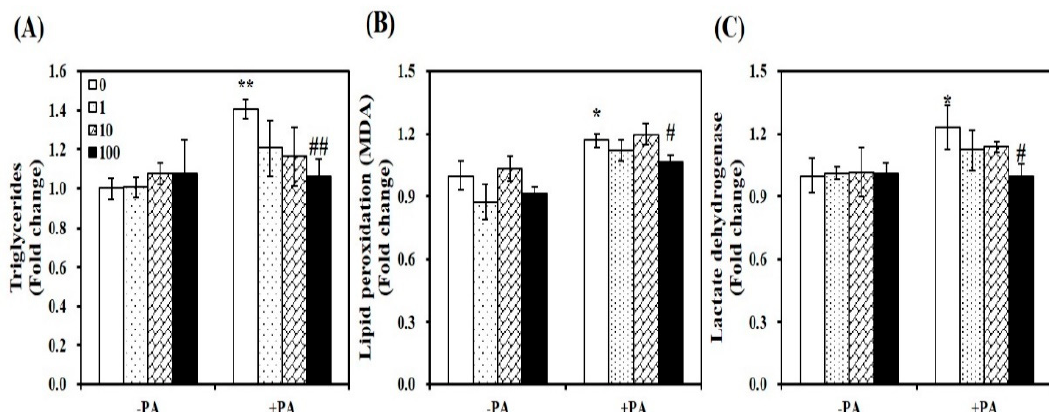
Figure 6. Inhibitory e ff ect of 1,25-dihydroxyvitamin D (1,25(OH)2D) on lipid accumulation, lipid peroxidation, and cellular damage. C2C12 myotubes were pretreated with palmitic acid (0.5 mM, 24 h) and then incubated with 1,25(OH)2D (0, 1, 10, or 100 nM, 24 h). Intramyocellular triglyceride concentrations ( A ), malondialdehyde (MDA) contents ( B ), and lactate dehydrogenase (LDH) levels ( C ) were expressed as the fold change compared to the vehicle control. Results are expressed as mean ± SEM. Experiments represent at least two or three independent experiments ( n = 6–10 per group). * p < 0.05; ** p < 0.01 compared to vehicle control. # p < 0.05; ## p < 0.01 compared to PA control.